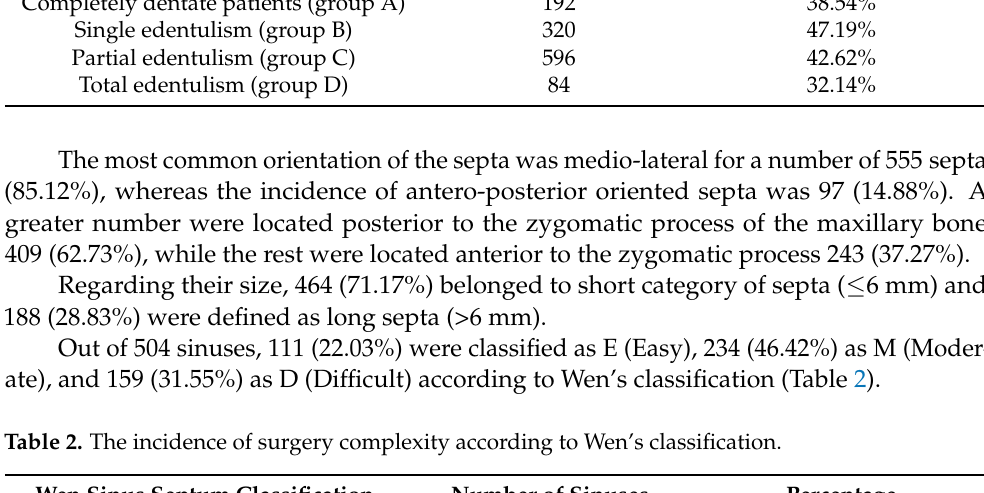
Table 2. The incidence of surgery complexity according to Wen’s classification. Wen Sinus Septum Classification Number of Sinuses Percentage Easy/A 77 15.28% Easy/B 34 6.75% Medium/A 161 31.94% Medium/B 73 14.48% Difficult/A 35 6.95% Difficult/B 18 3.57% Difficult/C 106